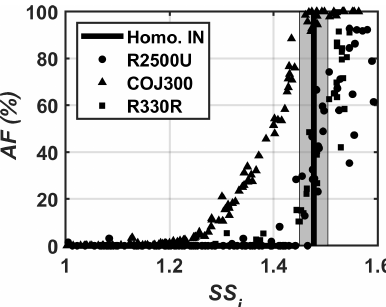
Figure 4. A representative − 45 ◦ C SS i scan of 400nm bare BC par- ticles, showing AF as a function of SS i . The black line is the homo- geneous freezing threshold for 200nm aqueous droplets at − 45 ◦ C (Koop et al., 2000). The gray shading indicates 1 standard deviation of variability for SPIN lamina SS i